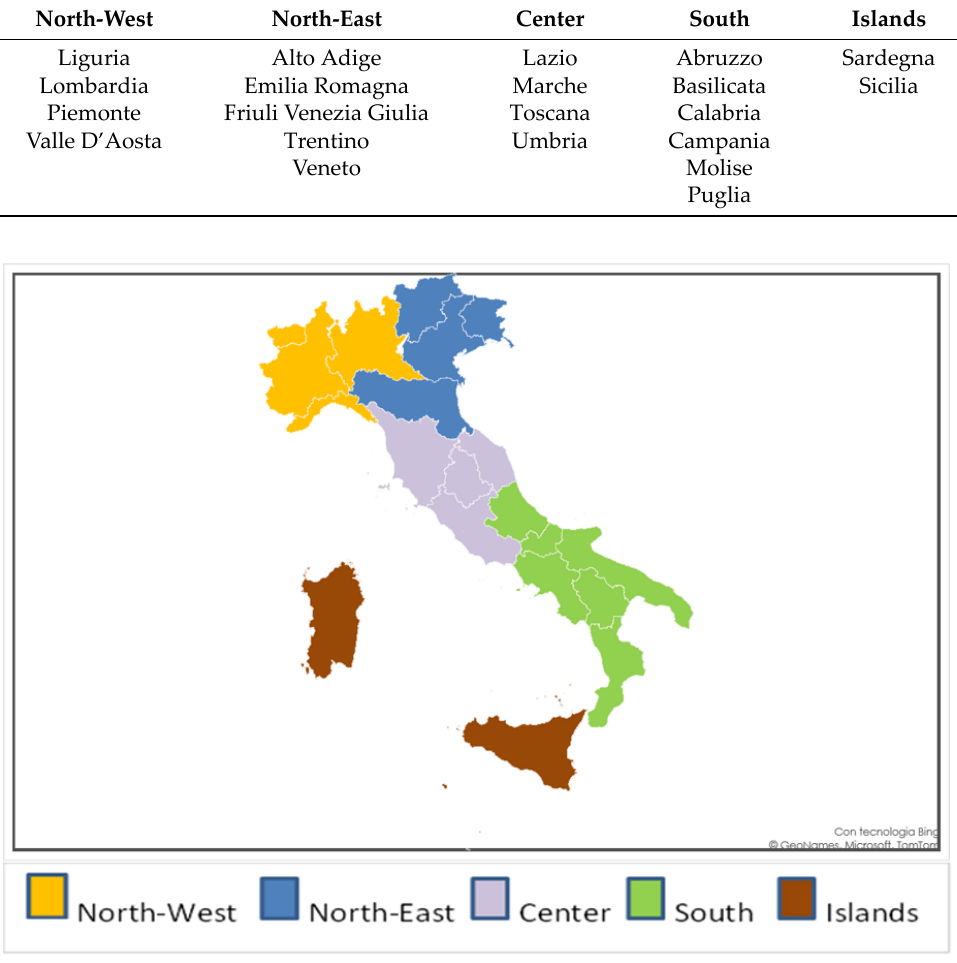
Figure 2. Representation of geographical Italian districts.